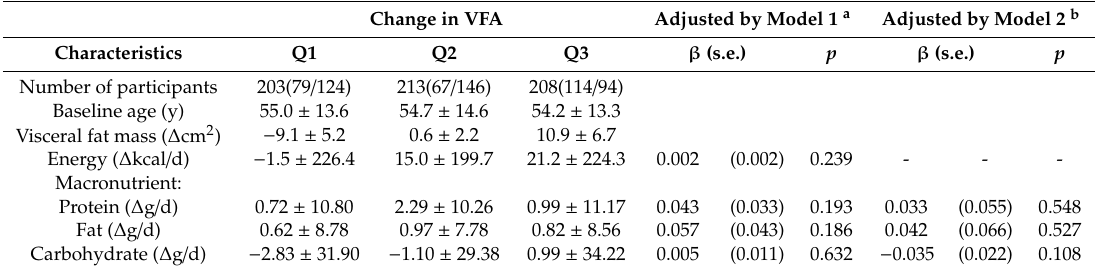
Table 2. Association between VFA and macronutrient change over 2 years.